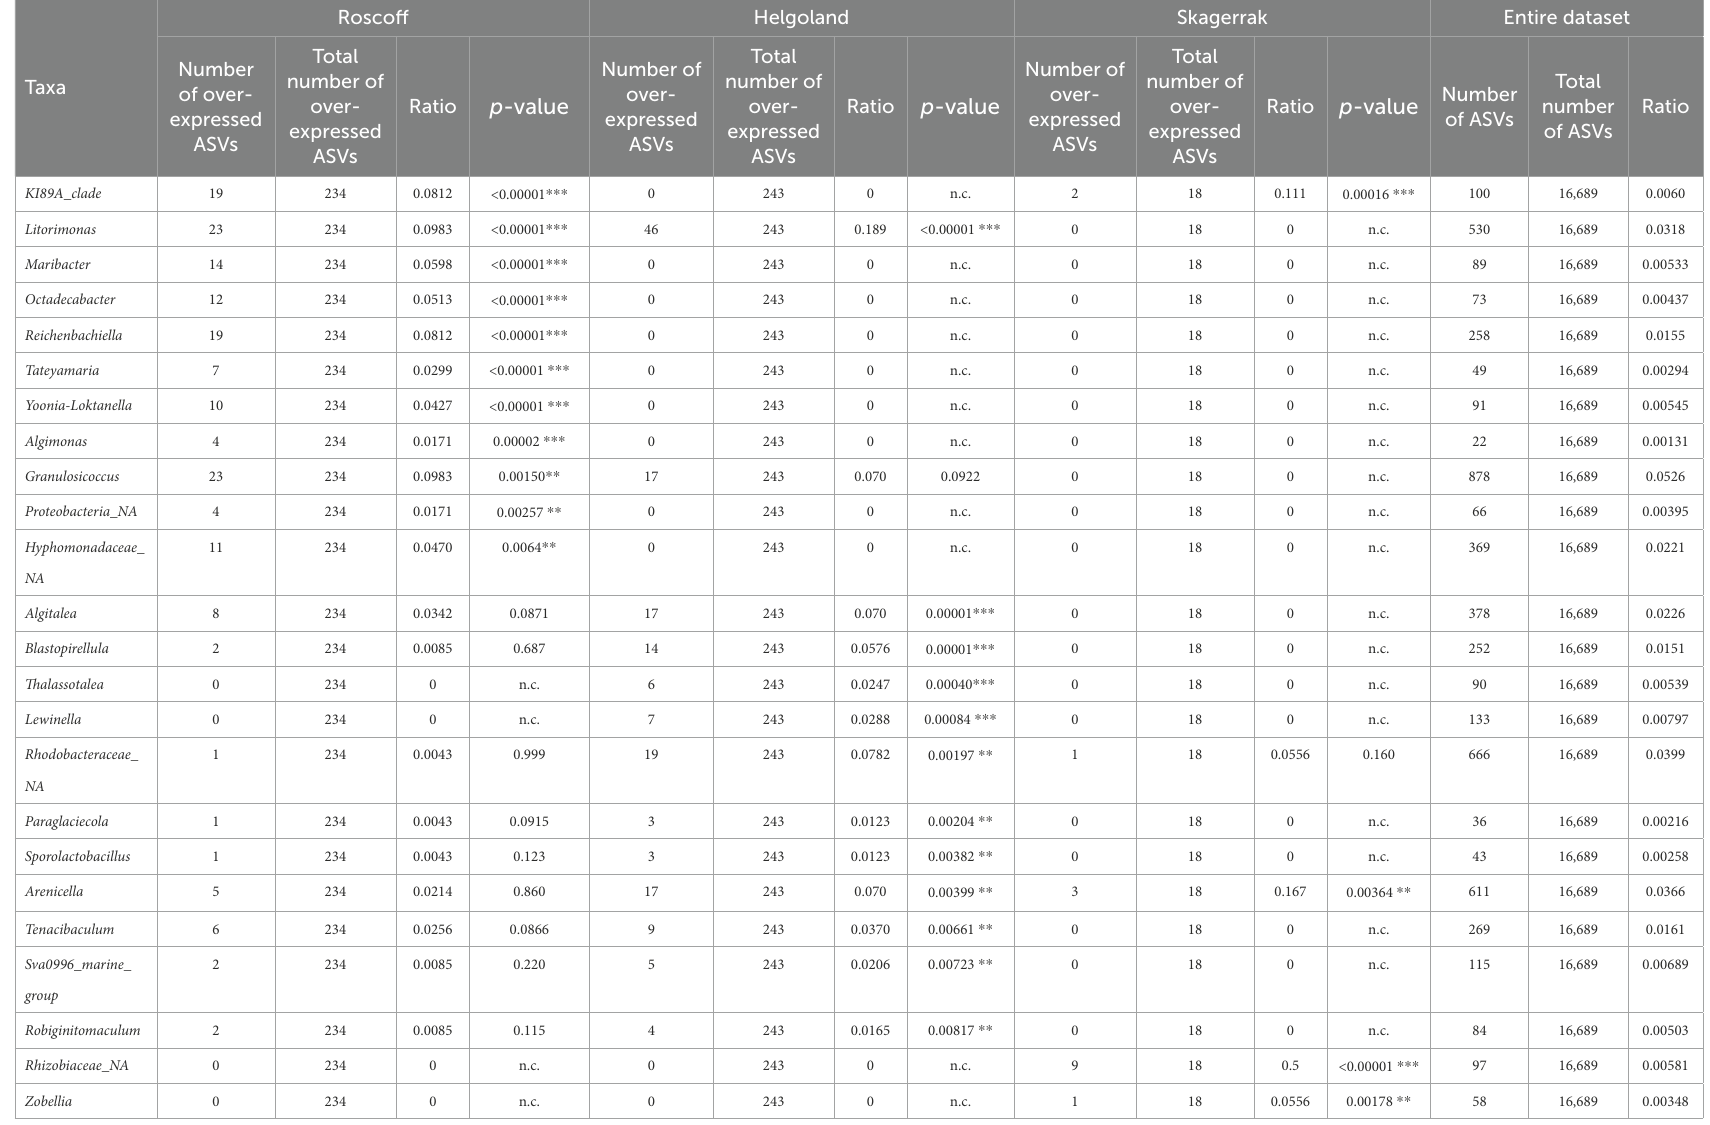
TABLE 3 Taxonomic affiliations of the ASVs characteristic for the Roscoff, Helgoland, or Skagerrak samples, compared with their occurrence in the entire dataset.